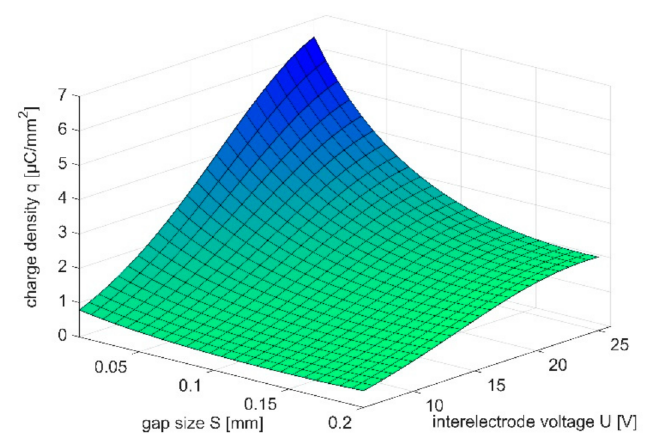
Figure 9. Relation q ( S , U ) for 5% water solution of NaNO 3 as electrolyte.